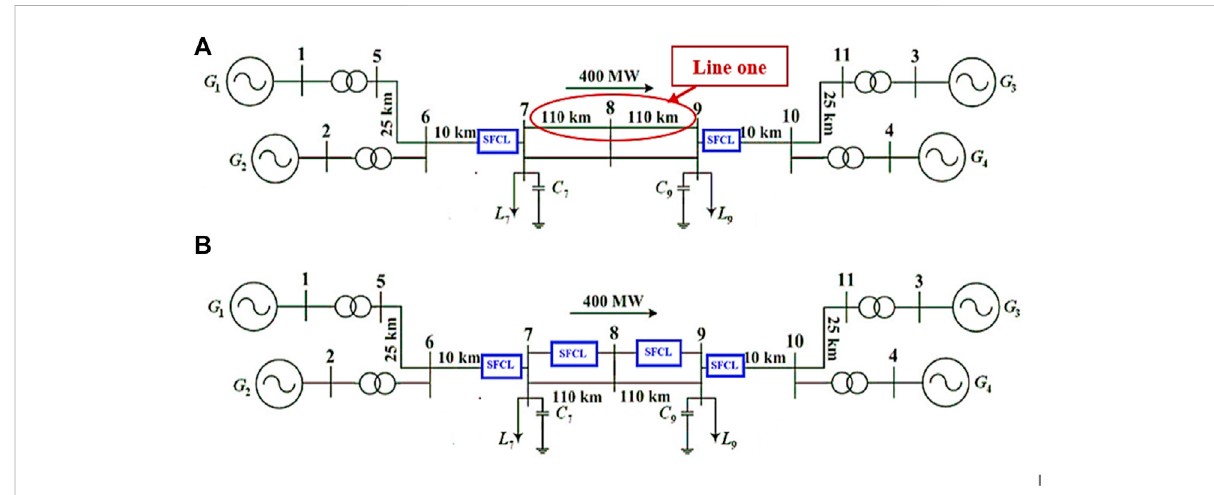
Two area system (A) case 1. (B) Case (2).